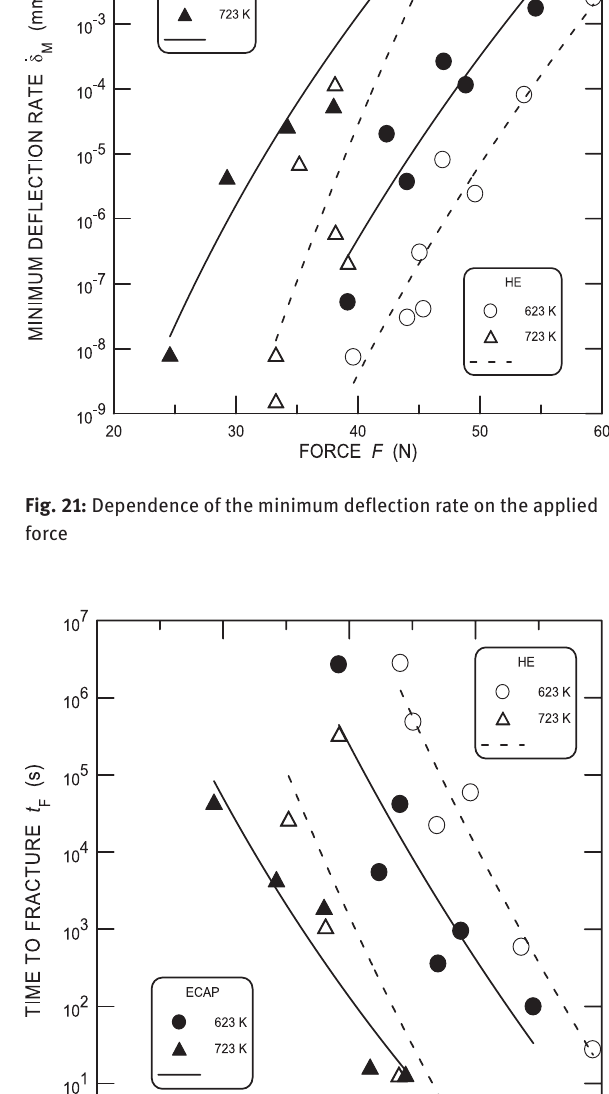
is smaller than in the previous case of deflection rate: